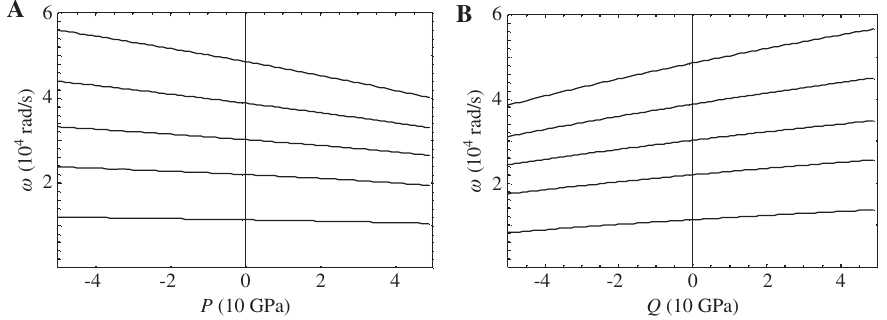
Figure 10 Frequency curves vs. initial stresses for the linearly graded cylindrical plate with η = 2 at kh = 3: (A) initial stress P : (B) initial stress Q